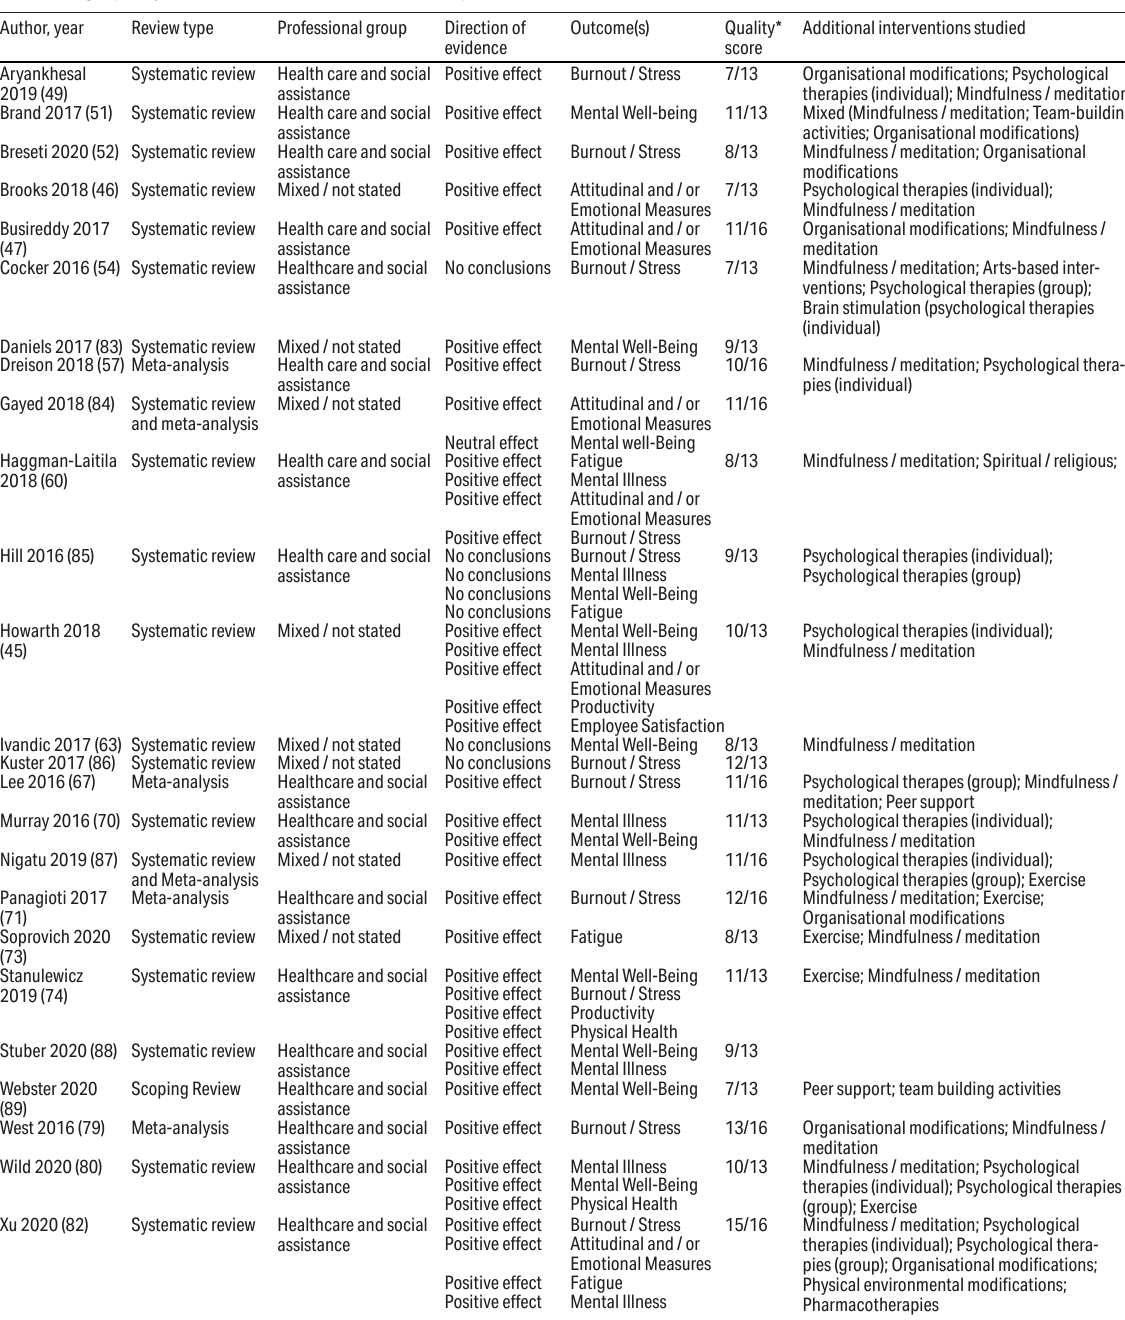
Table 2. High quality reviews of education and information